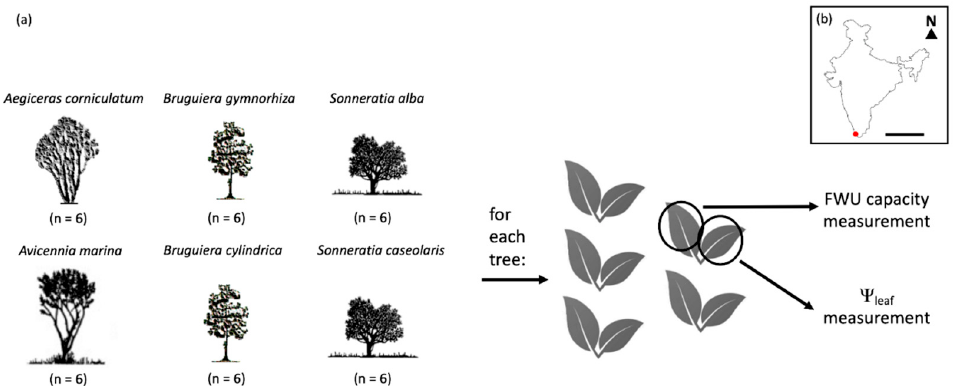
Figure 1. ( a ) Schematic overview of the leaf sampling of six mangrove species belonging to four different genera: Aegiceras corniculatum ( A.c .), Avicennia marina ( A.m .), Bruguiera cylindrica ( B.c. ), Bruguiera gymnorhiza ( B.g .), Sonneratia alba ( S.a .) and Sonneratia caseolaris ( S.c .). From each node, one leaf was used for the foliar water uptake (FWU) capacity experiment, and one leaf was used for the water potential ( Ψ leaf ) measurement with the pressure chamber. The illustrations of the trees are adapted from Lovelock [49] and Spalding et al. [1]. ( b ) The location of Ashtamudi Lake in India, where the species samples were collected. Scale bar = 1000 km.